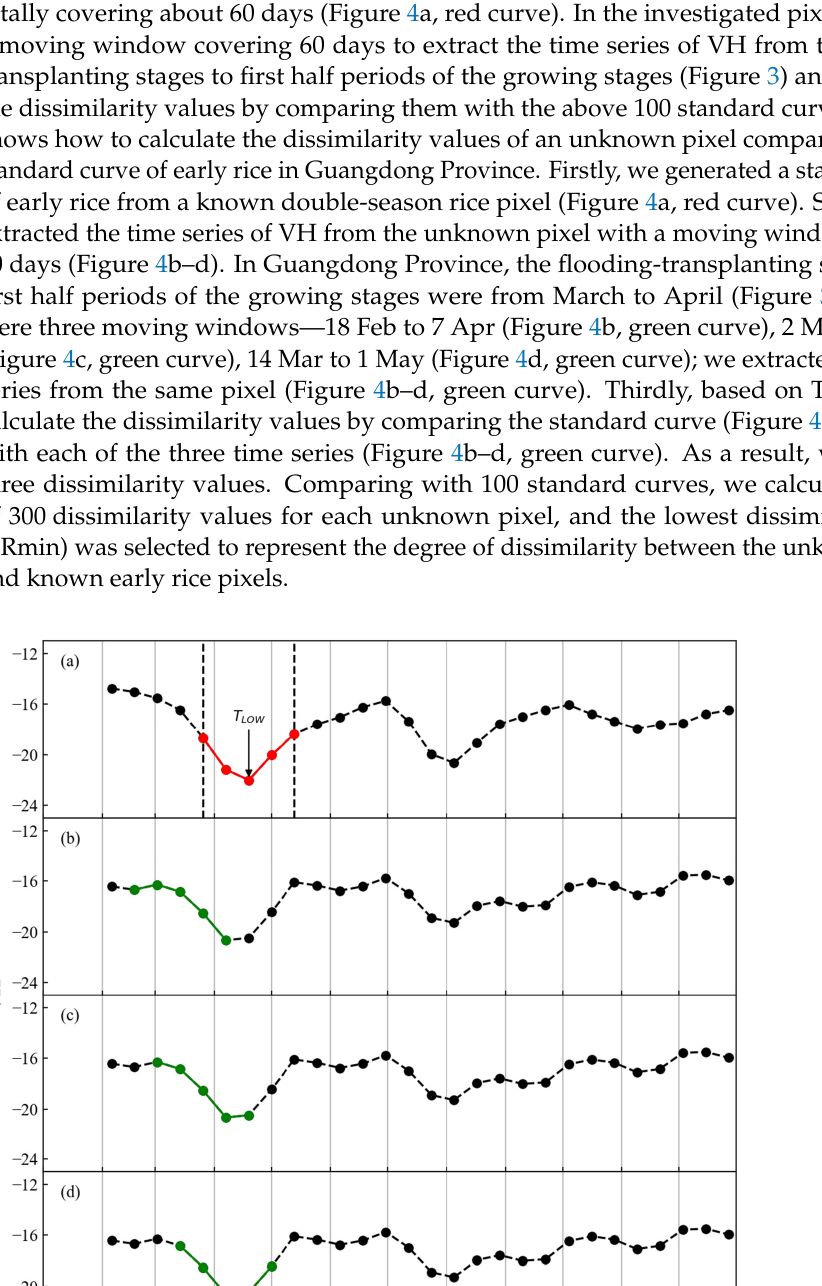
Figure 4. The temporal series of VH at a double-season paddy rice pixel ( a ) and red curve means a standard VH curve covering five times (60 days). The temporal series of VH at an unknown pixel applied with three moving windows respectively ( b – d ) and green curve means an extracted unknown curve covering five times (60 days). Following the same process, we also calculated the lowest dissimilarity value of late rice (LRmin) by comparing the standard VH curves of late rice with the VH curve of un- known pixels. The fields planting early rice also plant late rice in the same year, so the study used the sum of ERmin and LRmin to represent the degree of dissimilarity between the unknown pixel and known early rice pixels (ERdist). We first identified planting areas of early rice-late rice type (i.e., Type I) based on the TWDTW method by comparing ERdist of all pixels. Then we chose LRmin to represent the degree of dissimilarity between the unknown pixel and known other crops-late rice pixels (LRdist). In each province, the area differences of late rice and early rice were used to determine the thresholds of LRdist for identifying planting areas of other crops-late rice type (i.e., Type II) based on the TWDTW method. 2.4. Satellite Data This study used the Ground Range Detected (GRD, Level-1) product from Sentinel- 1, which has dual-polarized vertical transmission with VV (vertical transmit/vertical re- ceive) and VH (vertical transmit/horizontal receive) bands. We composited the VH data from 2016 to 2020 into corresponding 12-day mean images. Each image was processed to perform thermal noise removal, radiometric calibration, terrain correction and obtain the